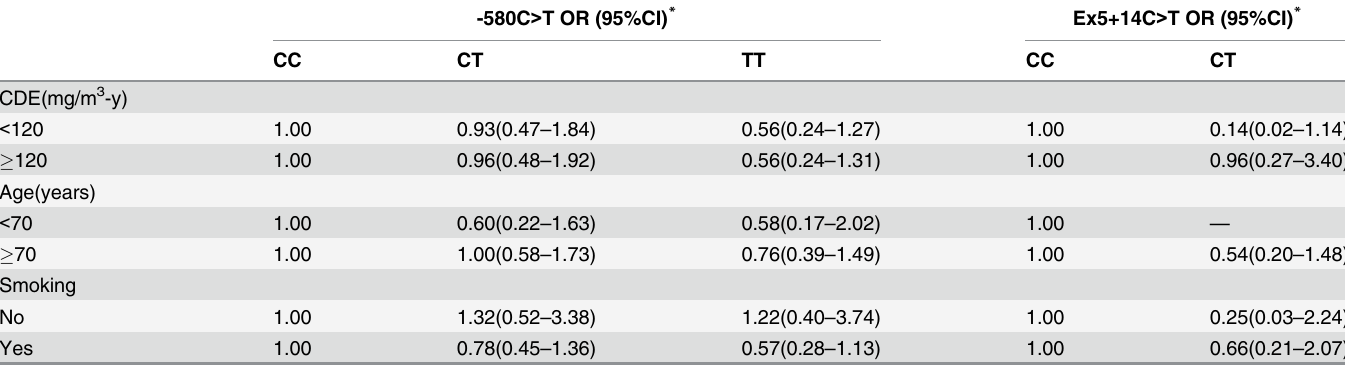
were not different between patients with silicosis and subjects in control group. After adjusting for age, smoking status, and CDE, the frequency of the GA genotype for the Ex2+37G > A poly- morphism in caspase-1 was significantly higher among silicosis cases than controls (OR [95% The results of our stratification analysis for the SNPs of Nalp3 are presented in Table 4. Among subjects younger than 70 years old, individuals with the CC genotype of IVS8- 7652A > C in Nalp3 had a lower risk of silicosis than individuals with other genotypes (OR [95%CI] = 0.24[0.06 – 0.88]). Among subjects older than 70 years, individuals with the T allele of Ex4-849C > T in Nalp3 had a higher risk of silicosis than those with other genotypes (OR [95%CI] = 2.52 [1.04 – 6.12]); the T allele was also associated with a higher risk of silicosis in The results of our stratification analysis for the SNPs of IL-1 β are presented in Table 5. We did not observe any significant interactions between the 2 SNPs in IL-1 β and CDE, age, or smoking status. Table 5. Stratification analysis for associations between genotypes of IL-1 β and the risk of silicosis. -580C > T OR (95%CI)